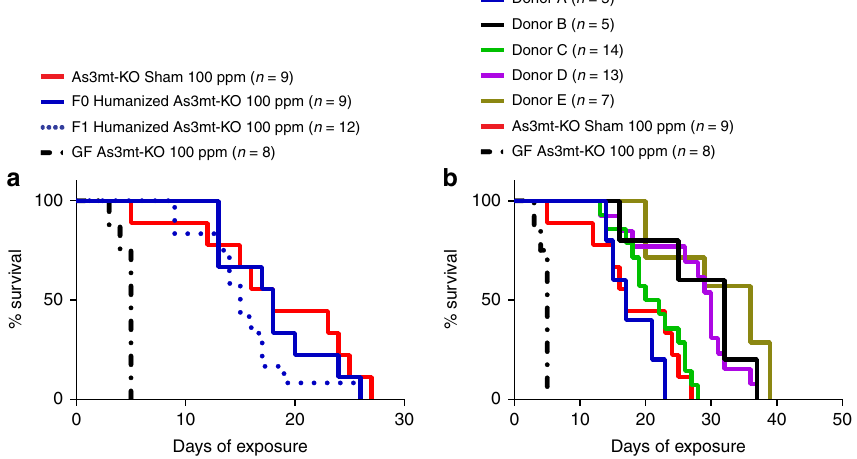
Fig. 3 Survival of iAs V -exposed humanized As3mt-KO mice. Groups of As3mt-KO mice (i.e., two or three replicate cages containing between two and fi